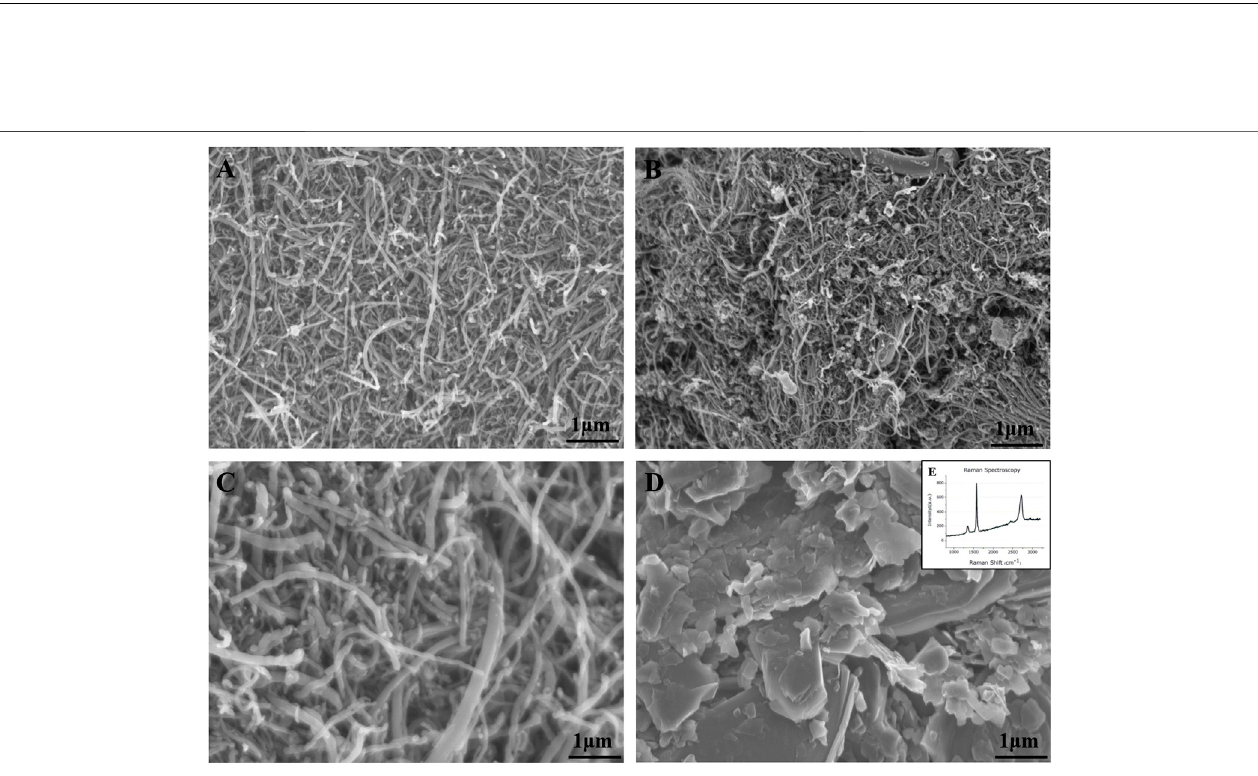
Frontiers in Materials |